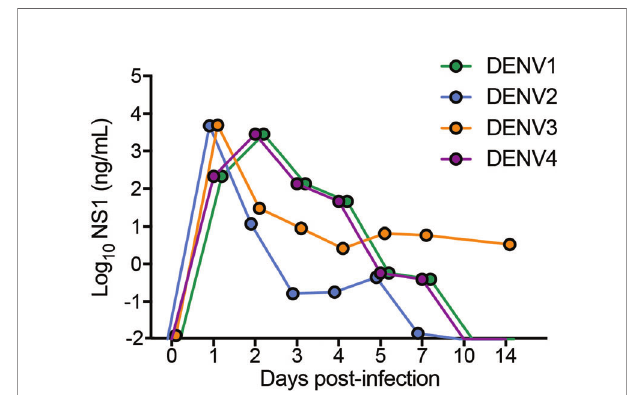
FIGURE 2 | Detection and quanti fi cation of secretory non-structural protein, NS1 in the serum of DENV1-4 infected WT mice. Sera from mice infected with each of the DENV serotypes, DENV1-4 was collected at indicated time points for 14 days and soluble NS1 was quanti fi ed in the serum at each time points post-infection. NS1 antigen was present in all the groups (DENV1-4) for a period of 5-7 days peaking at days 2-3 for DENV1 and DENV4 and at day 1 for DENV2 and DENV3 respectively. Baseline values are shown as day